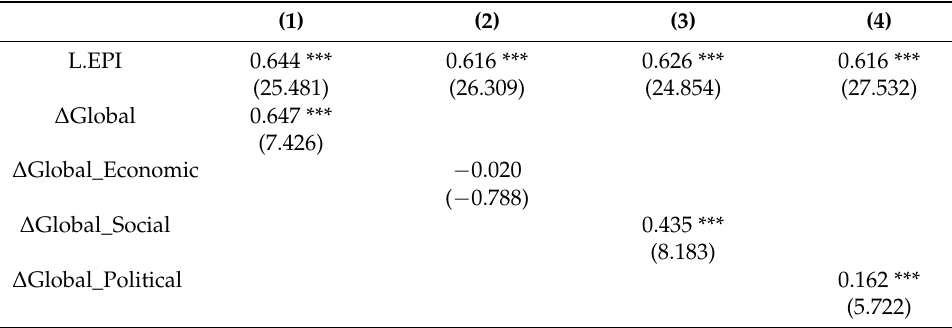
Table 6. Robustness test—slowing or accelerating